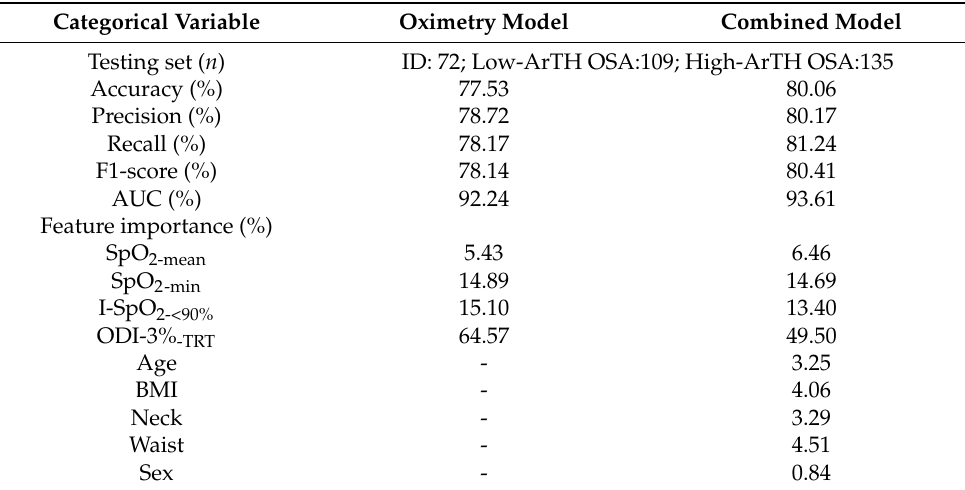
Table 4. Classification performance and feature importance of the selected models (random forest) in the prediction of the testing set.